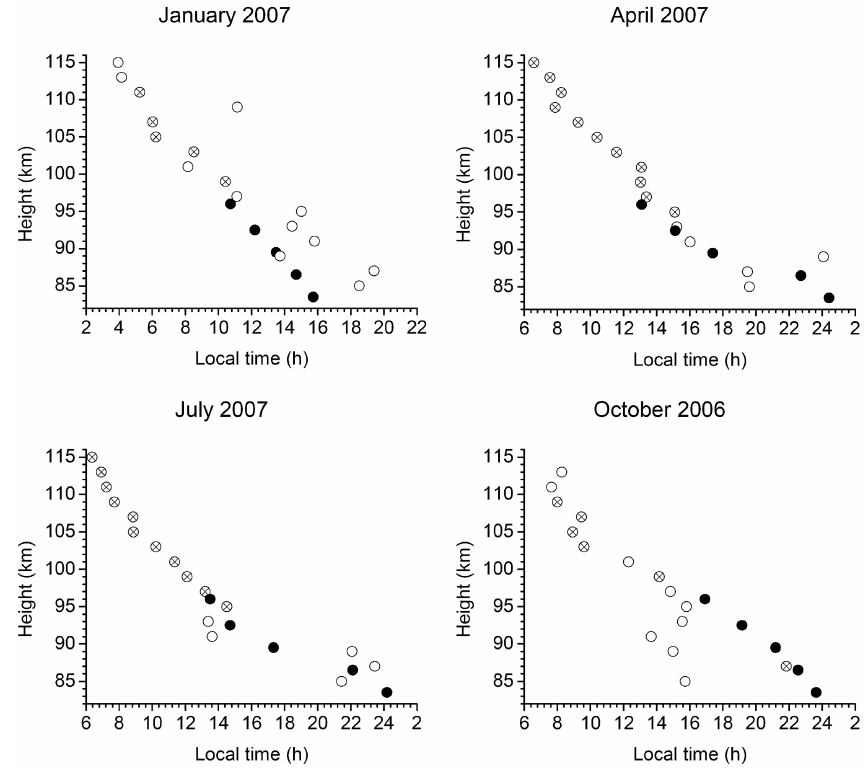
Fig. 6. Semidiurnal phases of Collm meteor radar zonal wind shear, defined as time of minimum vertical shear (solid dots), and CHAMP, GRACE and FORMOSAT-3/COSMIC relative E s layer occurrence (open circles), defined as time of maximum occurrence. E s phase values with statistical significant amplitudes are marked by a cross ( × ) inside the